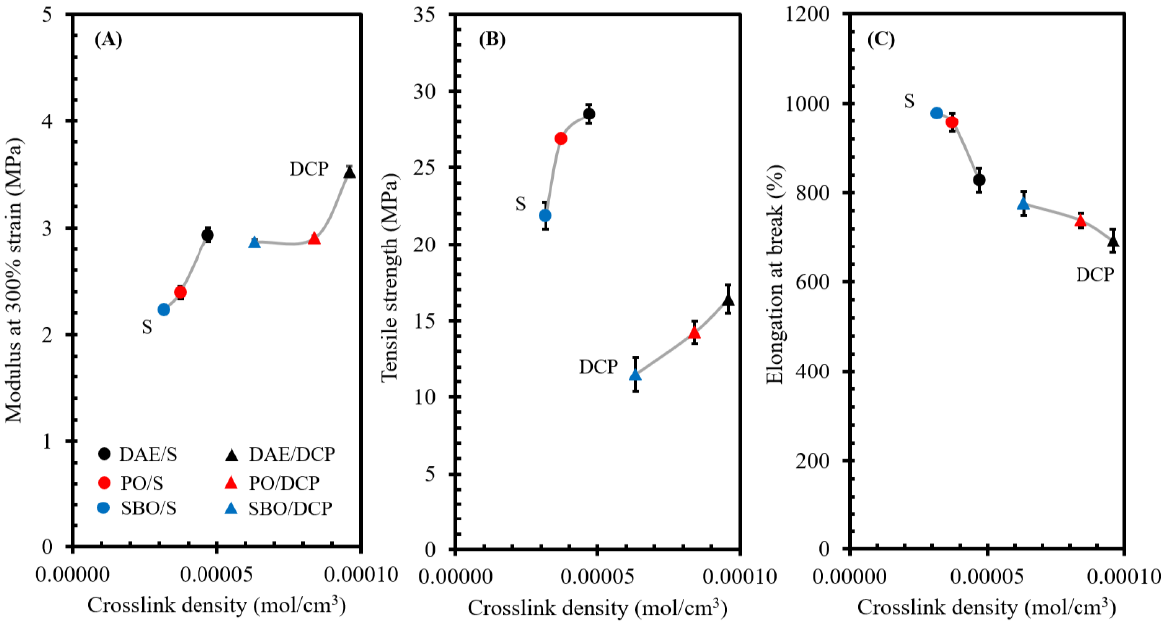
Figure 11. Modulus at 300% strain ( A ), tensile strength ( B ), and elongation at break ( C ) as a function of the crosslink density of NR compounds containing different types of oils and cured by various curing systems. Table 2. Tensile properties, i.e., modulus at 300% strain, tensile strength, and elongation at break, of rubber compounds cured with different curing systems and change on the properties of rubber compounds containing bio-oils compared to DAE.